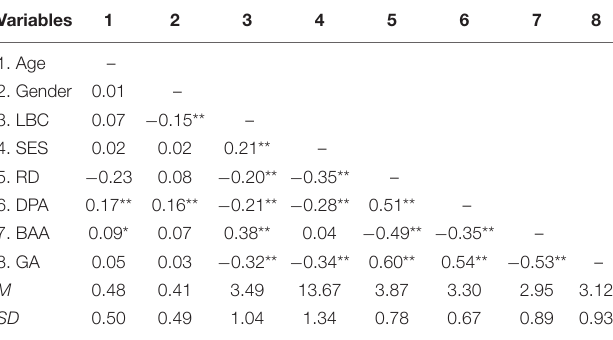
TABLE 1 | Means, standard deviations, and correlations of the main study